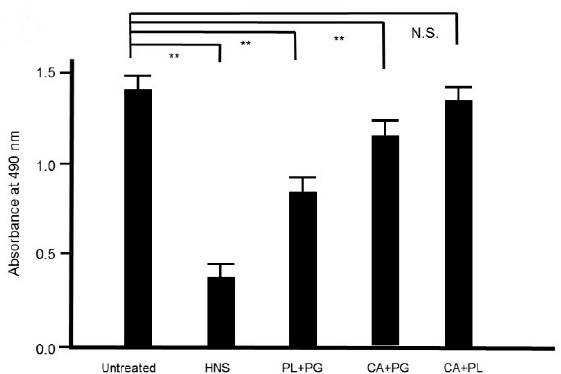
Figure 8. Inhibitory effects of the HNS constituents on the biofilm formation by S. mutans . S. mutans were treated with the constituents of HNS for 48 h, and stained with safranin red. The concentrations of the samples used were as follows: HNS, 500 μg/mL; extracts of Paeoniae Radix (PL) and Platycodon Radix (PG) mixture, 194 and 127 μg/mL, respectively; extracts of Aurantii Fructus Immaturus (CA) and PG mixture, 179 and 127 μg/mL, respectively; and extracts of CA and PL mixture, 179 and 194 μg/mL, respectively. Data show the mean ± S.D. ( n = 6). **: p < 0.01 by Tukey’s multiple comparison tests. NS: not significant.